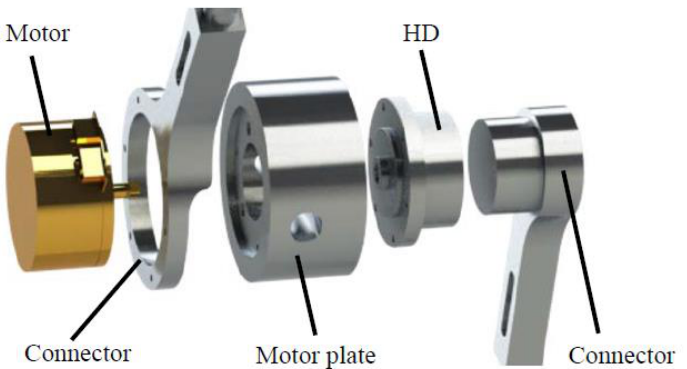
Figure 8. Knee joint design of the LLRE-II.